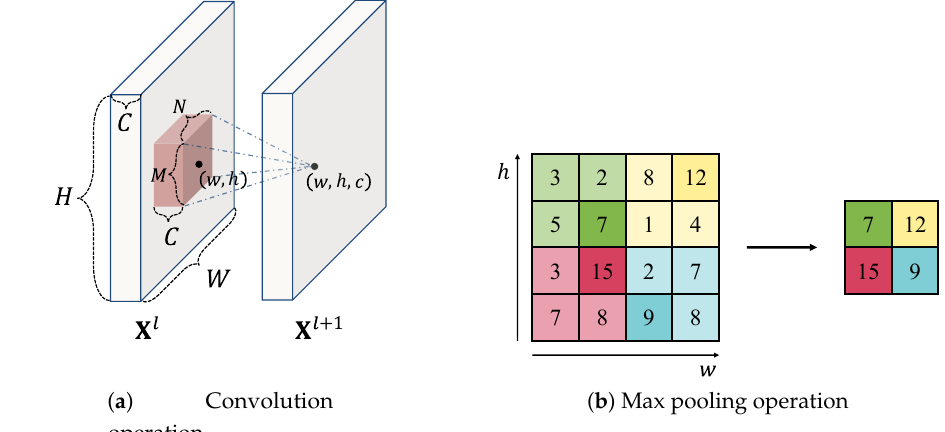
Figure 11. Convolution and max pooling operations in